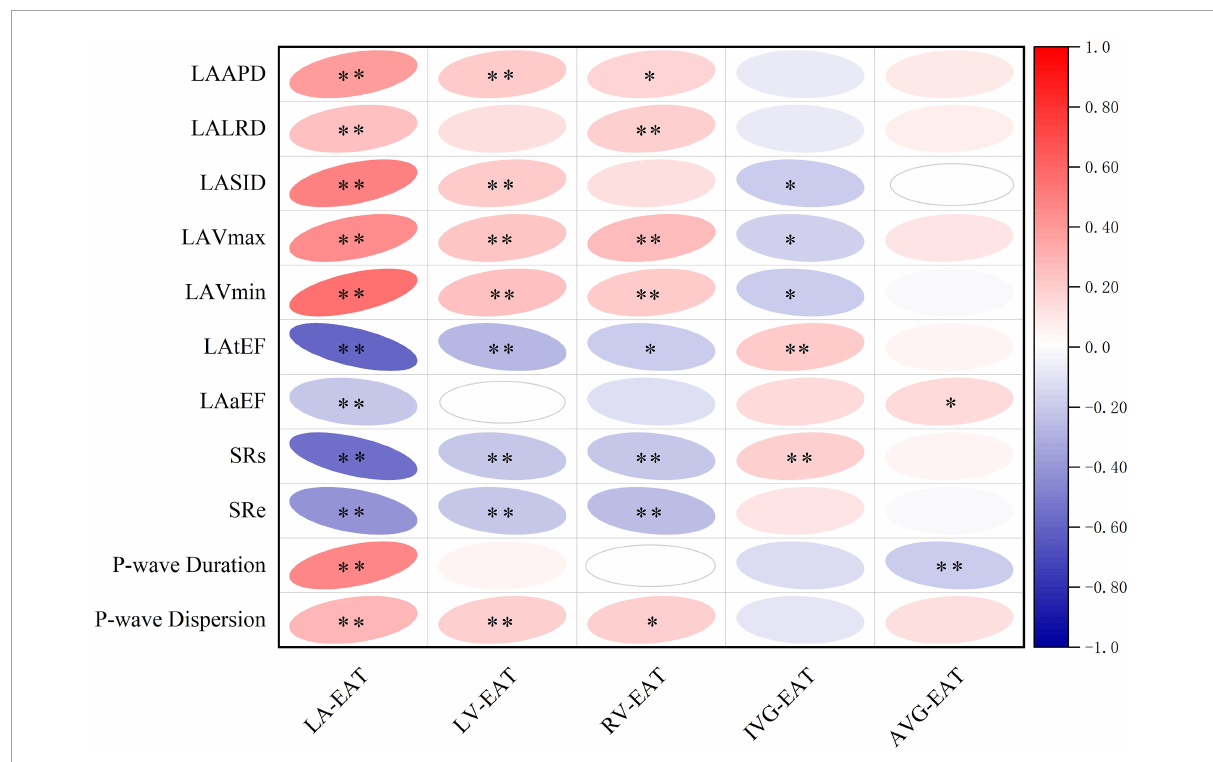
FIGURE5 Correlation of EAT in different regions of the heart with LA remodeling and dysfunction in AF patients. ∗ P < 0.05, ∗∗ P < 0.01. EAT, epicardial adipose tissue; LA-EAT, mean EAT thickness surrounding left atrium; LV-EAT, mean EAT thickness surrounding left ventricle; RV-EAT, mean EAT thickness surrounding right ventricle; IVG-EAT, mean EAT thickness in interventricular grooves; AVG-EAT, mean EAT thickness in atrioventricular groove; LAAPD, LA anteroposterior diameter; LALRD, LA left and right diameter; LASID, superior and inferior diameter of left atrium; LAVmax, LA maximum volume; LAVmin, LA minimum volume; LAtEF, LA total emptying fraction; LAaEF, LA active ejection fraction; SRs, strain rate during ventricular systole; SRe, strain rate during early ventricular